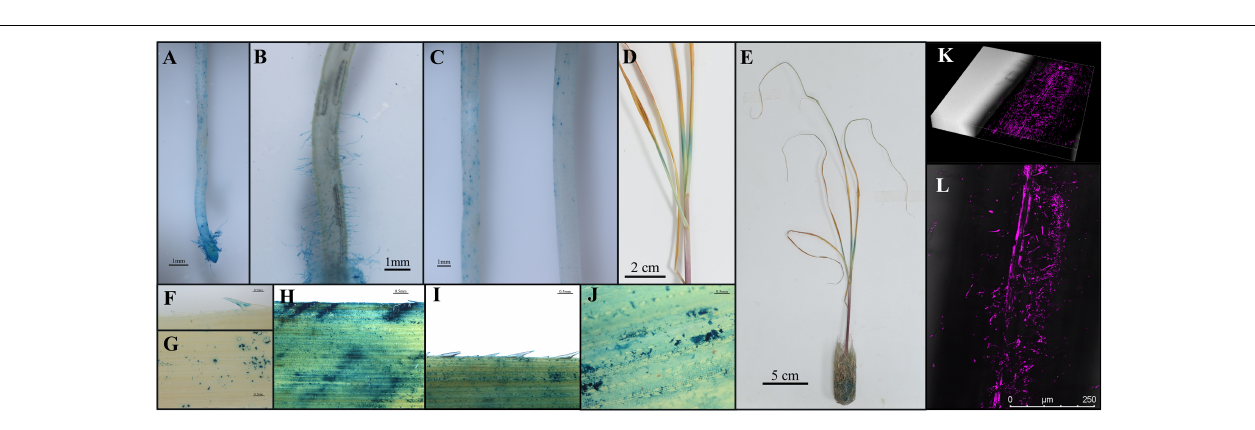
FIGURE 5 | Colonization pattern analysis of SRB-109 on sugarcane. GUS labeled SRB-109 was inoculated and co-cultured with sugarcane for 3 days in the growth chamber. Then, different organs of sugarcane plants were harvested for GUS staining. The blue color indicates the colonization of SRB-109 on different organs, including roots (A–C) and leaves (D–G) , along with GUS signals detected near inoculation wounds on leaves (H–J) . Results of colonization patterns of SRB-109 (RFP labeled) on the roots of sugarcane visualized with confocal microscopy (K,L)